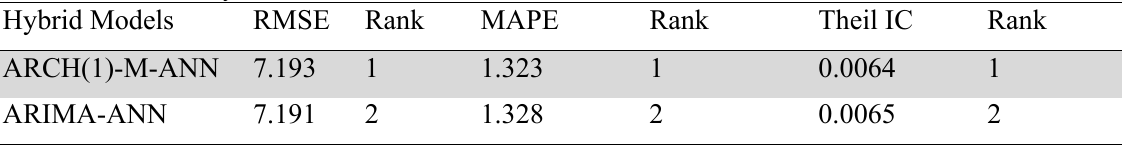
Forecast Result of Hybrid